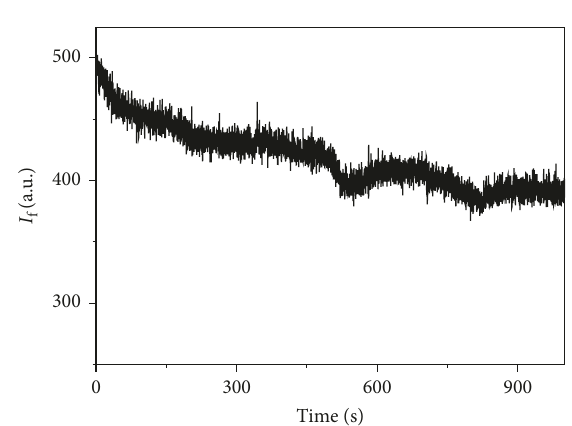
Figure 8: NIP response profile for a 1.28